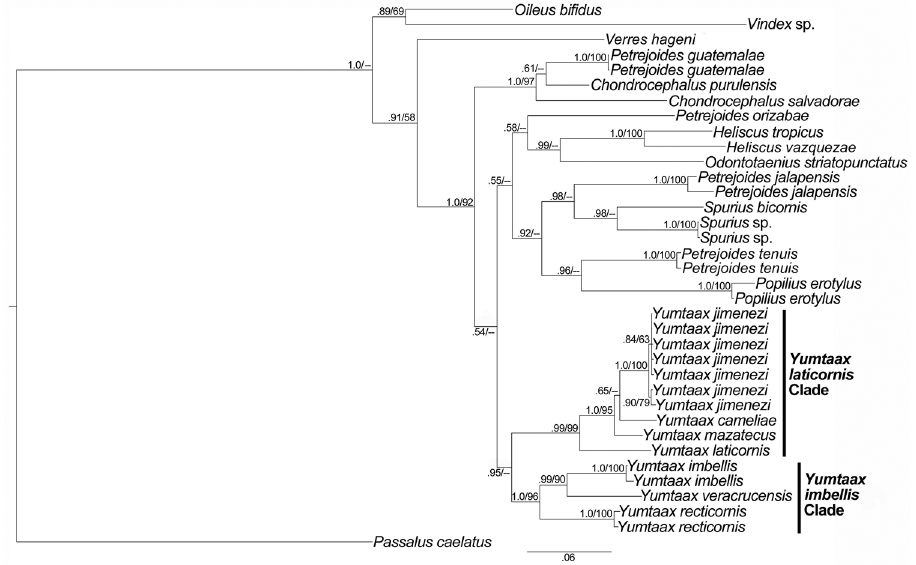
Figure 4. 50% majority-rule consensus of Bayesian posterior probabilities resulting from analysis of the combined data. Bayesian posterior probabilities (PP) (> 0.50) and bootstrap support (BS) (> 50) are noted. Yumtaax veracrucensis sp. n. = Yumtaax LCM; Yumtaax recticornis = Yumtaax recticornis OM; Yumtaax laticornis = Yumtaax CM; Yumtaax cameliae sp. n. = Yumtaax LM; Yumtaax jimenezi sp. n. = Yumtaax recticornis